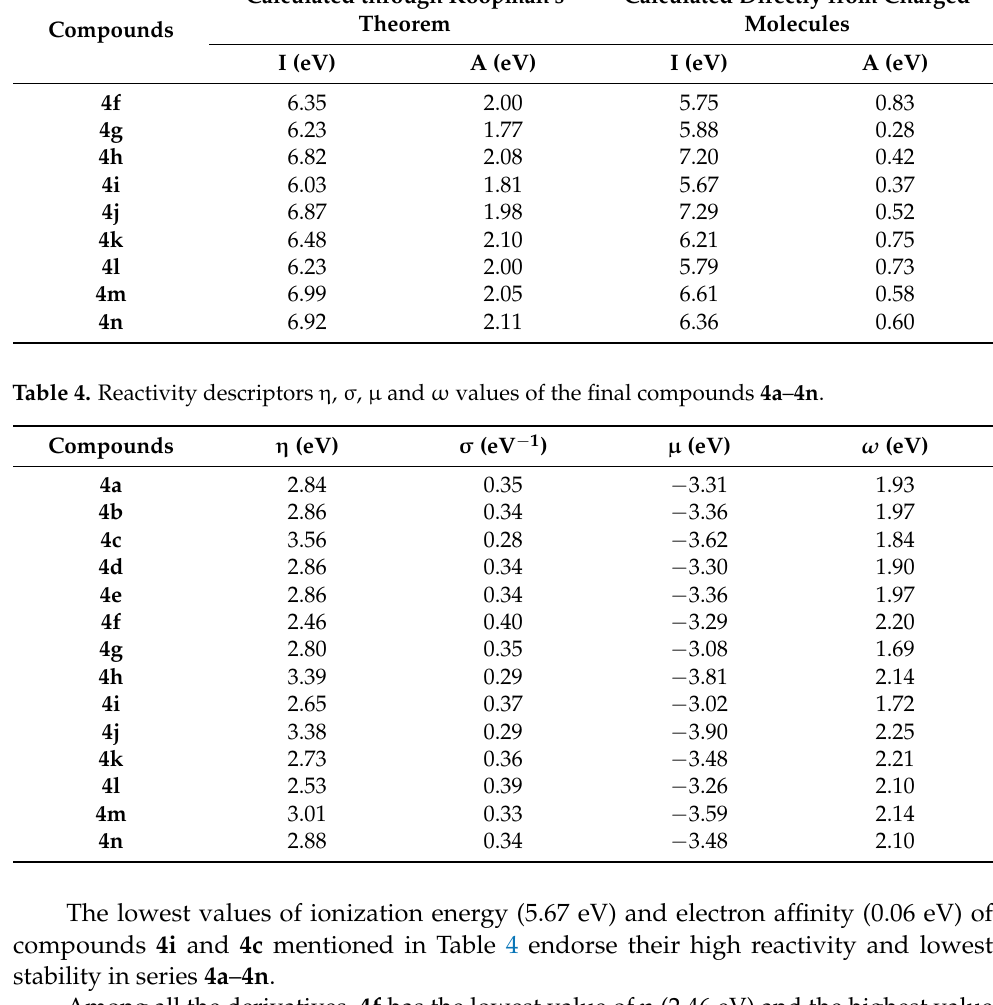
Calculated Directly from Charged Molecules